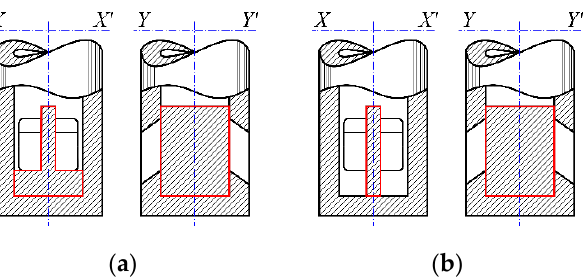
Figure 3. Inner geometry characteristics for the SEN proposed in this work. ( a ) Flat bottom with flow divider, FBFD. ( b ) Well bottom with flow divider, WBFD.